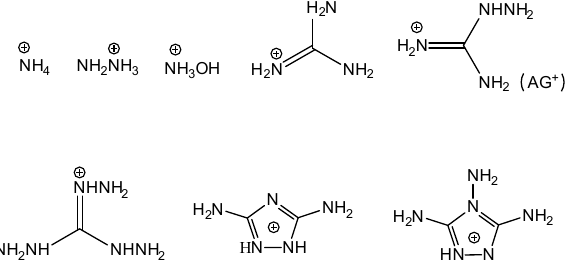
Figure 5. Some cations to balance charges of energetic metal–organic frameworks (EMOFs)[53].